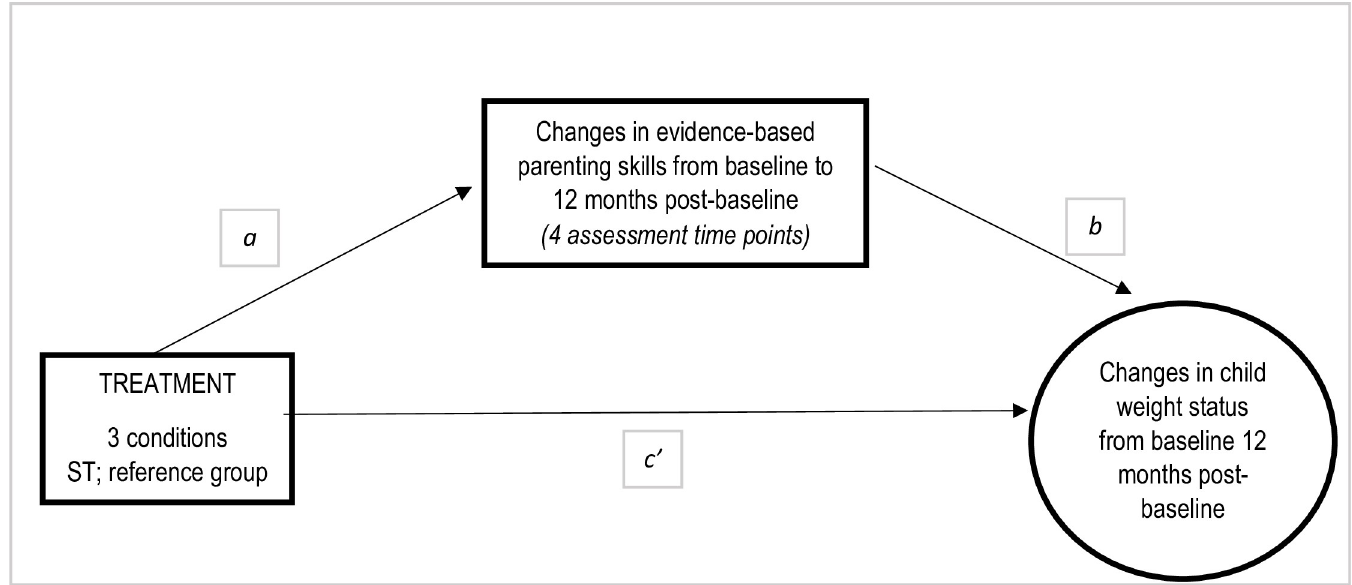
Fig 2. Model specification for mediation, changes in parenting practices is the proposed mediator. Treatment effects on the primary outcome (changes in child weight status at 12 months post-baseline) through changes in parenting practices (mothers’ and fathers’). Pathway a: Direct treatment effect on changes in parenting practices (mediator). Pathway b: Direct effect of changes in parenting practices (mediator) on the primary outcome controlling for treatment. Pathway c’: Direct treatment effect on the primary outcome adjusting for the proposed mediator. a � b: Indirect treatment effect on the primary outcome through the proposed mediator.